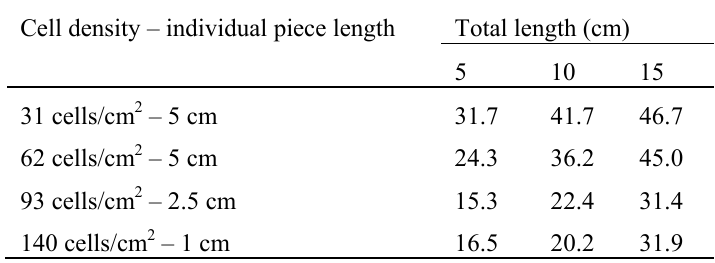
-t (min). From reference [40], with permission 0.95 0.05